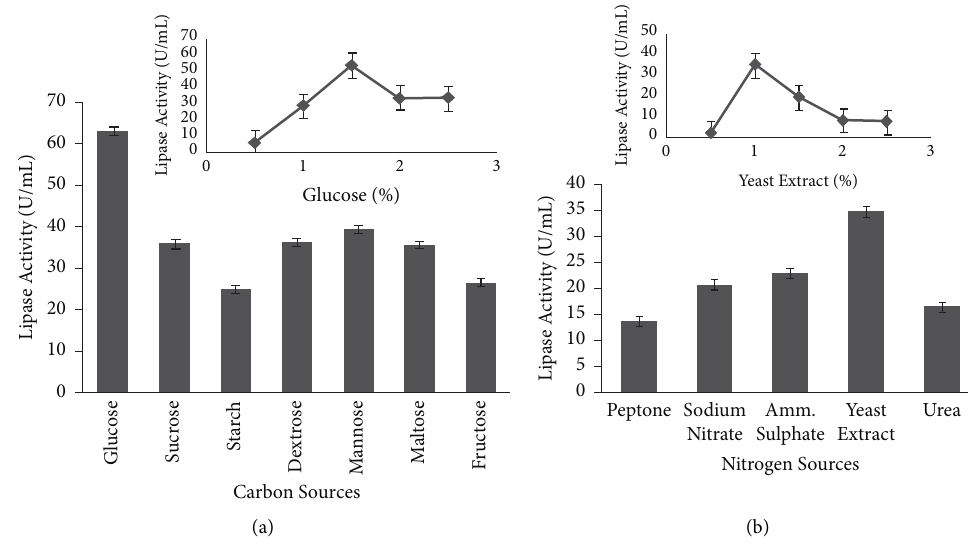
Figure 1: Effect of different (a) carbon sources and (b) nitrogen sources on lipase production by K . flava